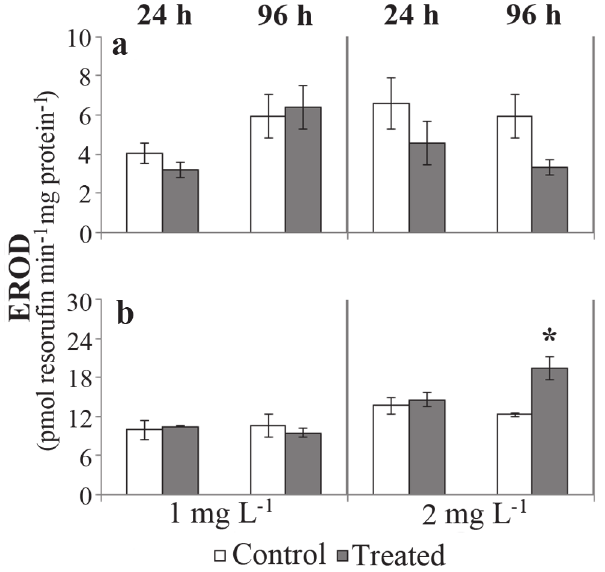
Fig. 1. Etoxiresorufina-O-desetilase (EROD) activity in gills ( a ) and liver ( b ) of Prochilodus lineatus exposed to 1 or 2 mg L -1 lyophilized Microcystis aeruginosa (treated) or only water (control), for 24 and 96 h. Values are presented as mean ± SEM (n = 8). Asterisk indicates significant difference when compared to respective control (p < 0.05).